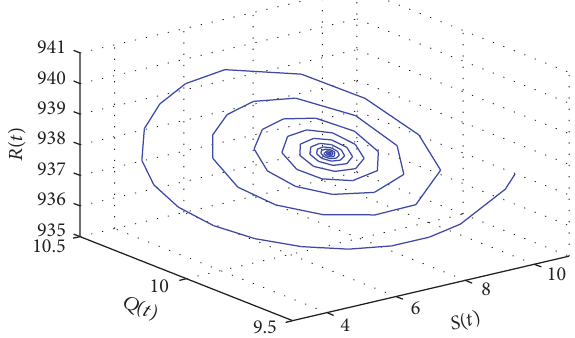
Figure 15: The phase plot of 𝑆 , 𝑄 , and 𝑅 when 𝜏 1 = 0.785 < 0.8903 = 𝜏 󸀠 10 and 𝜏 2 = 1.05